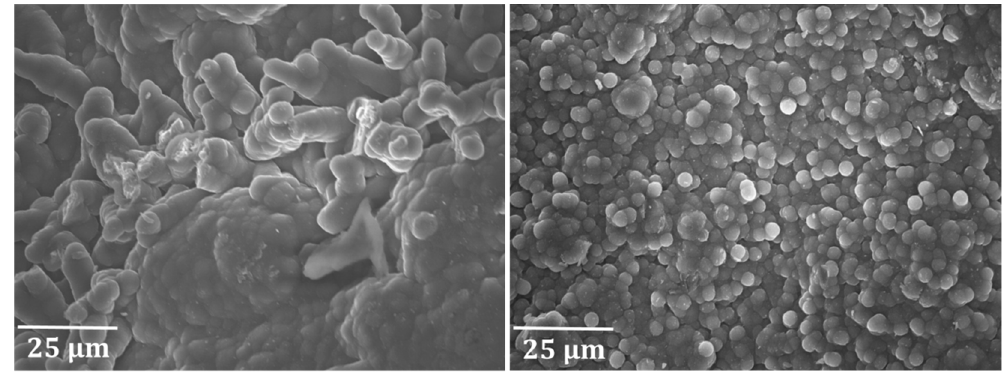
Figure 7. Coke structures recorded at an accelerating voltage of 20 kV on the top surface of the Ti–base alloy after applying pretreatment A and seven coking/decoking cycles followed by a 6 h coking.